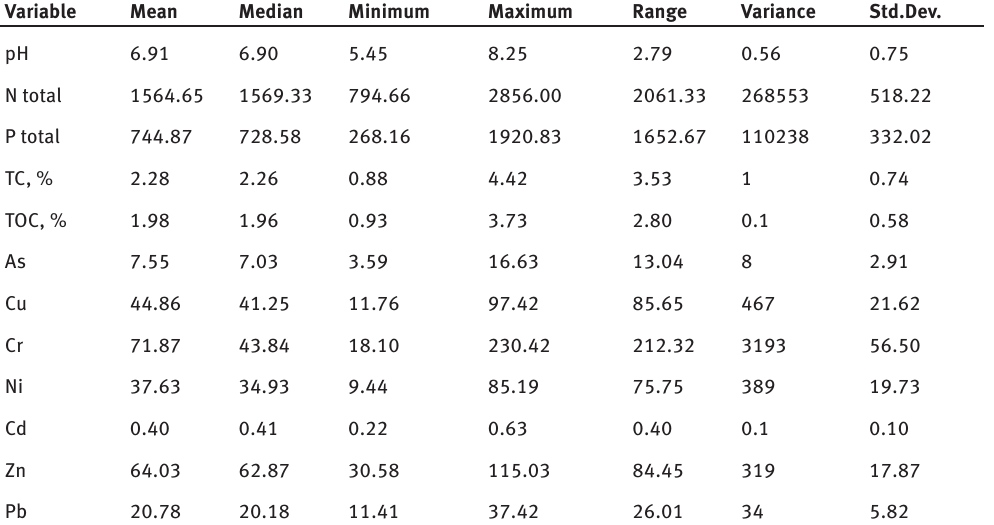
Table 1: Basic statistics of the input data (except for pH (log units), TC and TOC given as %, all other variables are in mg/kg). Variable